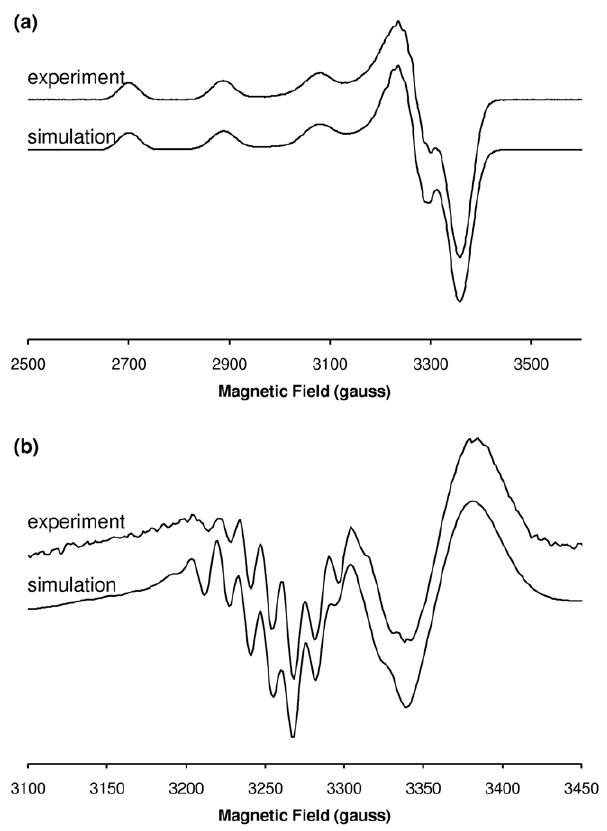
Figure 3. Simulation of the X-band CW-EPR spectrum of Cu 2 + / A b 1[isoAsp]–16 at pH 6.9. ( a ) First derivative. ( b ) Second derivative, expanded around g H region. Simulation parameters appear in Table 2. Experimental spectra correspond to the 13 C(1)-isoAsp1 labelled analogue.